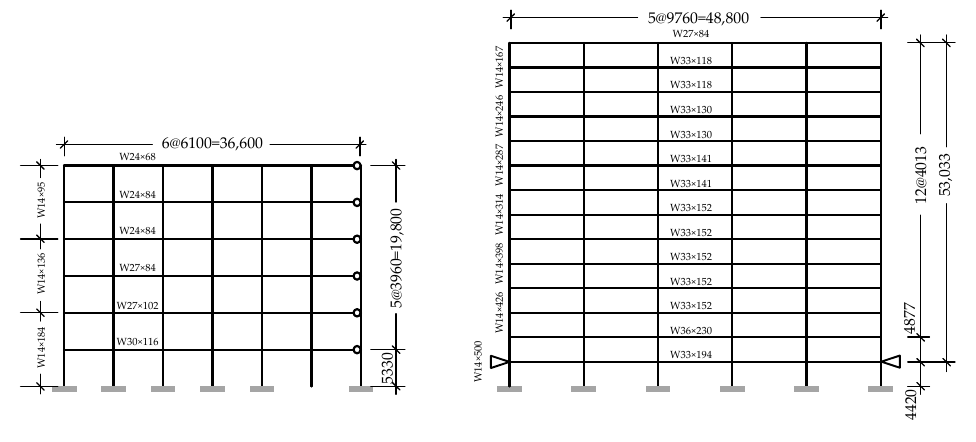
Figure 11. Elevation of the 6F and 13F buildings.